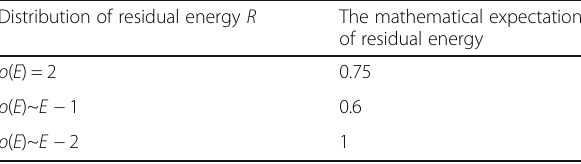
Table 2 Various distributions of residual energy Distribution of residual energy